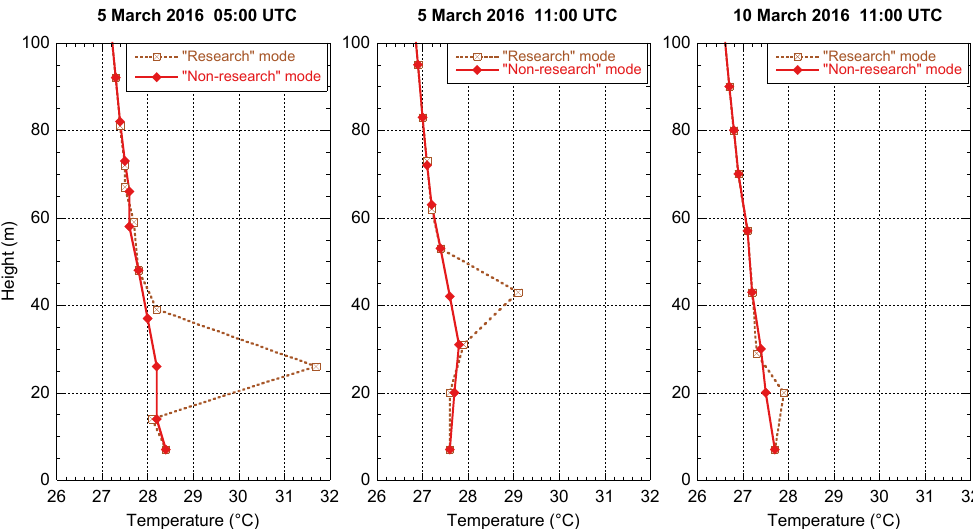
Figure 6. A comparison of “research mode” and “non-research mode” DigiCORA processing on temperature soundings believed to have been collected as the radiosonde passed through the exhaust plume of NOAA Ship Ronald H. Brown . The “non-research mode” soundings were used in the creation of the data sets described in the text. Data colors from www.ColorBrewer.org by Cynthia A. Brewer, Geography, Pennsylvania State